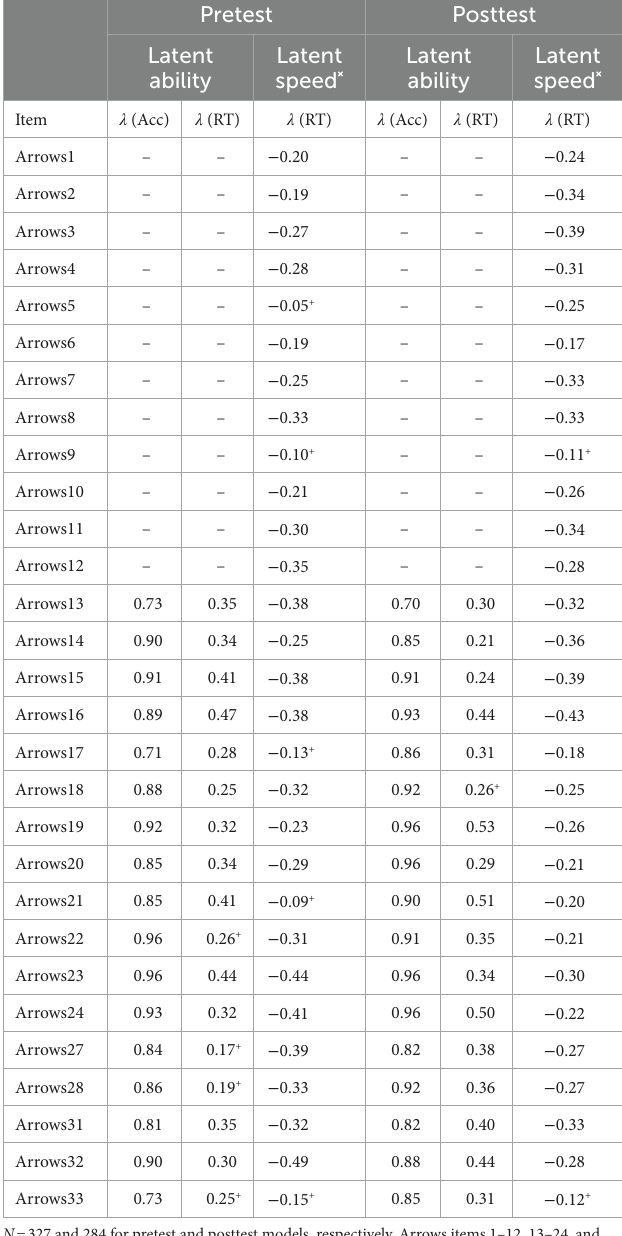
TABLE 2 Final Standardized loadings from the enriched arrows